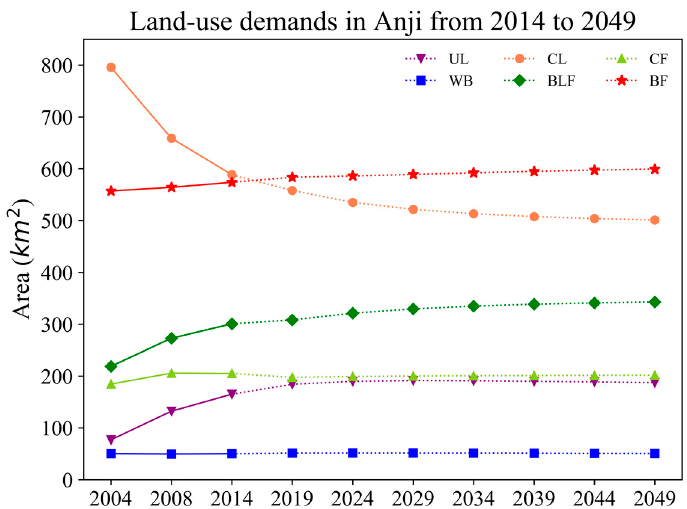
Figure 11. Area demands of each land-use type in Anji County from 2004 to 2049.